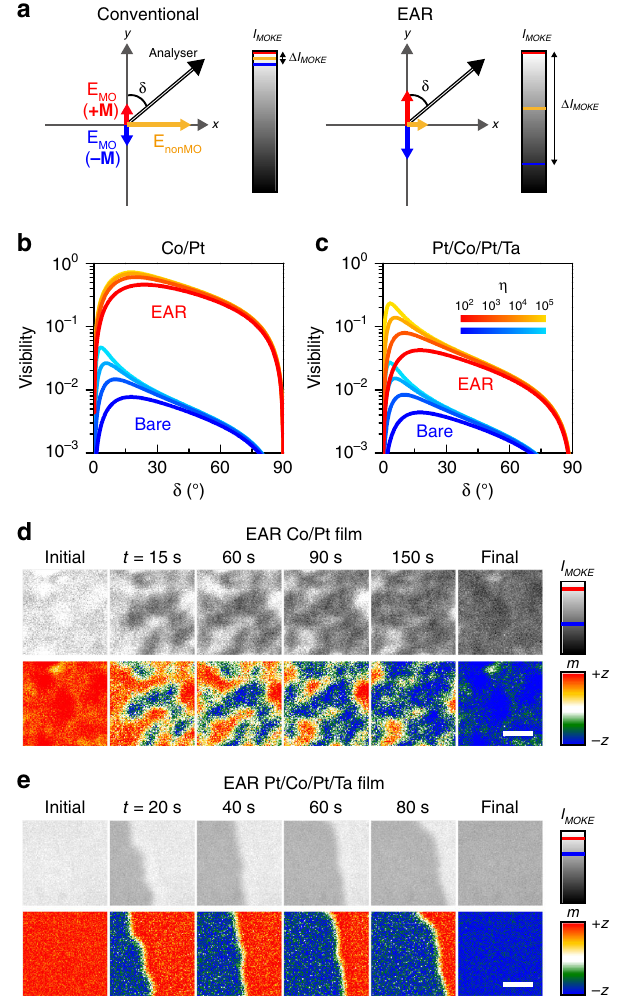
Fig. 3 High-visibility magnetic domain imaging and high-precision magnetisation measurement. a Schematic of the realisation of high- visibility MOKE microscopy by EAR. The yellow arrow represents the electric fi eld of the non-MO re fl ection. The red and blue arrows indicate the electric fi eld of the MO re fl ection from the magnetic media of magnetisation + M and − M , respectively. Here, + M ( − M ) is the magnetisation of the fully magnetised medium in the + z ( − z )